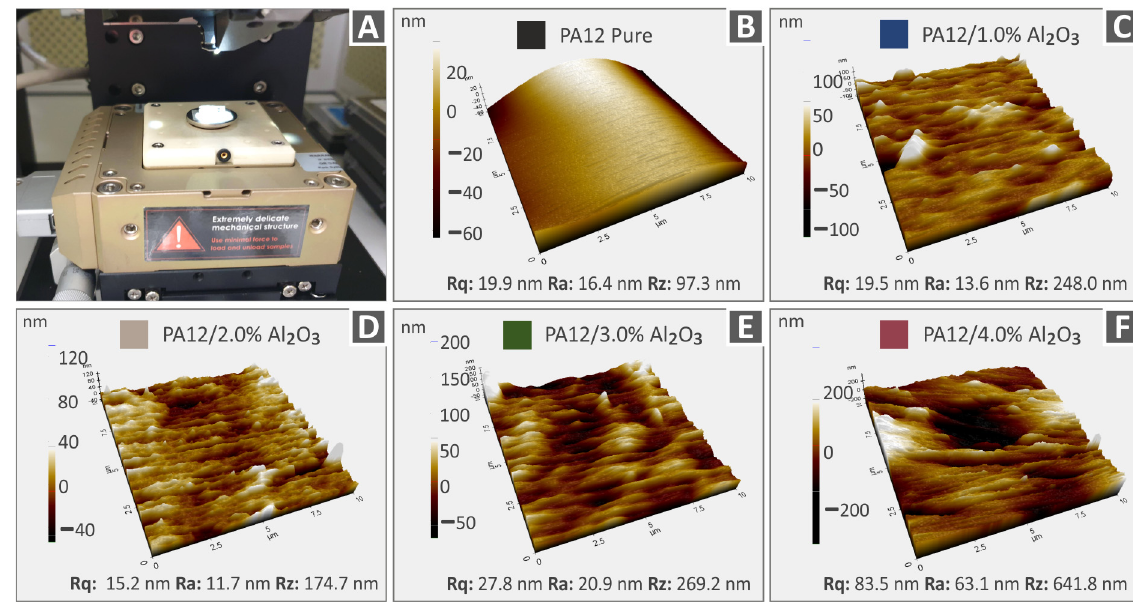
Figure 7. AFM topography images together with the corresponding roughness values (Rq, Ra, Rz) of PA12 and PA12/Al 2 O 3 nanocomposite filaments ( A ) AFM setup, ( B ) PA12 pure, ( C ) PA12/Al 2 O 3 1.0 wt.%, ( D ) PA12/Al 2 O 3 2.0 wt.%, ( E ) PA12/Al 2 O 3 3.0 wt.%, ( F ) PA12/Al 2 O 3 4.0 wt.%.